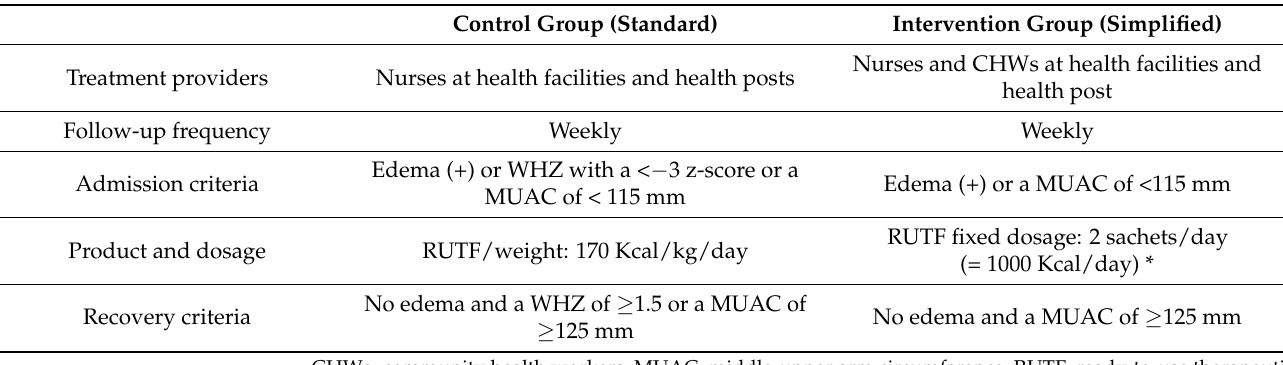
Table 1. Treatment characteristics of the two study